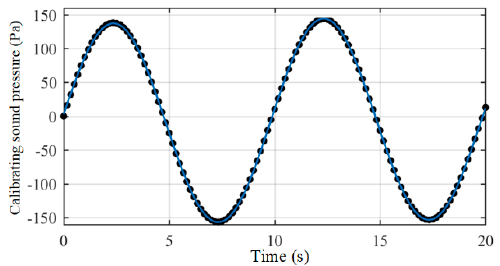
Figure 14. Waveform fitting at 0.1 Hz.